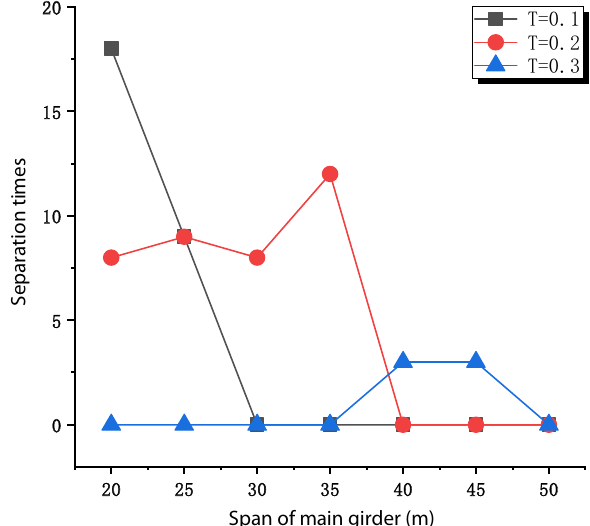
Figure 10. Bridge separation times under different girder spans.